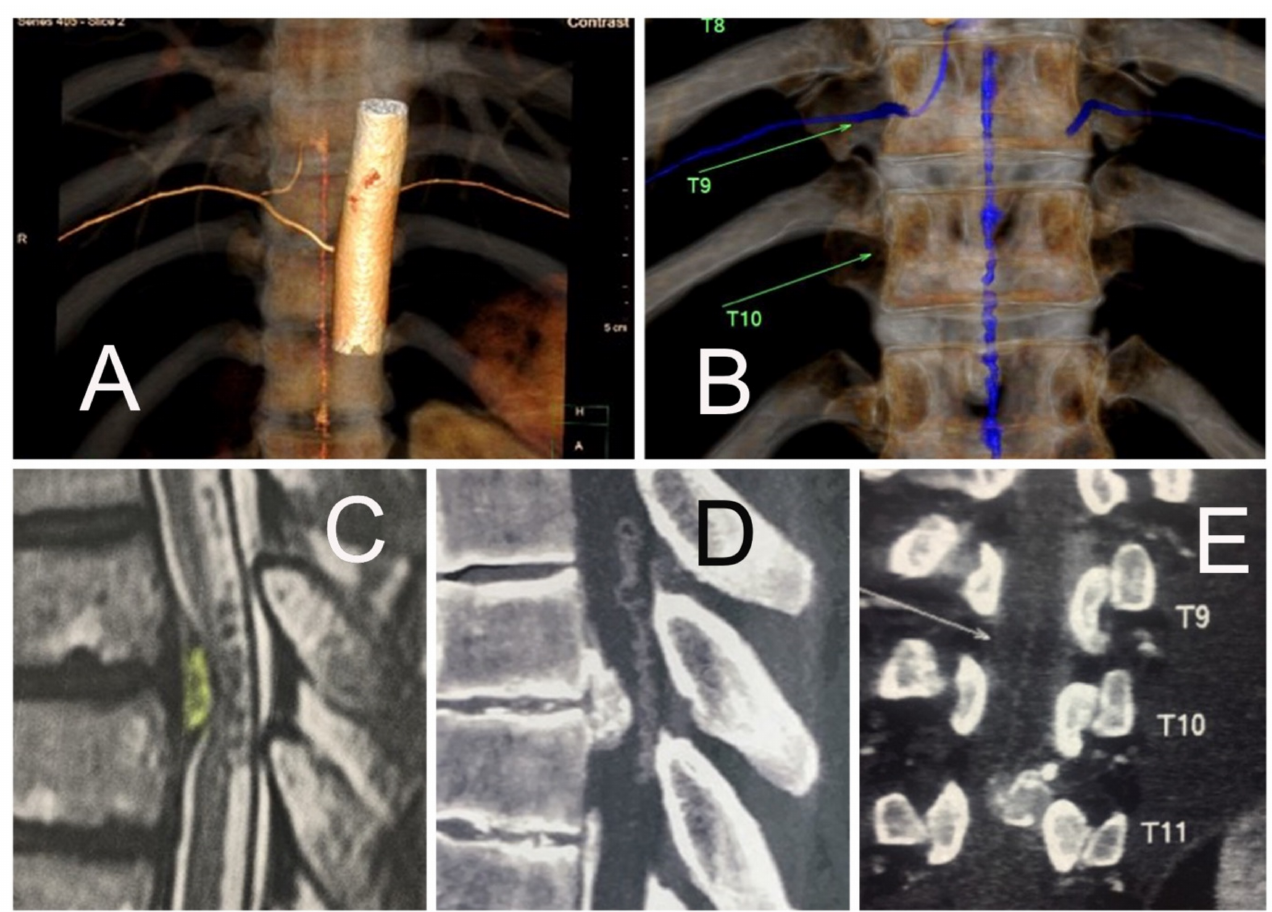
Figure 2. Various coronal CT angiography scans are shown ( A , B ) demonstrating the foraminal entry- level of the magna radicular artery at the T9-T10 and a medullary angioma, ( B ) at the same level of the thoracic disc herniation, ( C – E ) in the same patient at the T10-T11 level. The relationship between the thoracic surgical level and the foraminal entry-level of the blood supply to the Adamkiewicz system should be studied preoperatively before decompression. The causal use of electrocautery to improve visualization or access to the compressive pathology should be avoided. Unintended spinal cord ischemia during the endoscopic operation of the thoracic spine may result in postoperative neurological deficits. In this case, the surgeon decided to cancel the transforaminal endoscopic discectomy procedure because of the heightened risk of spinal cord